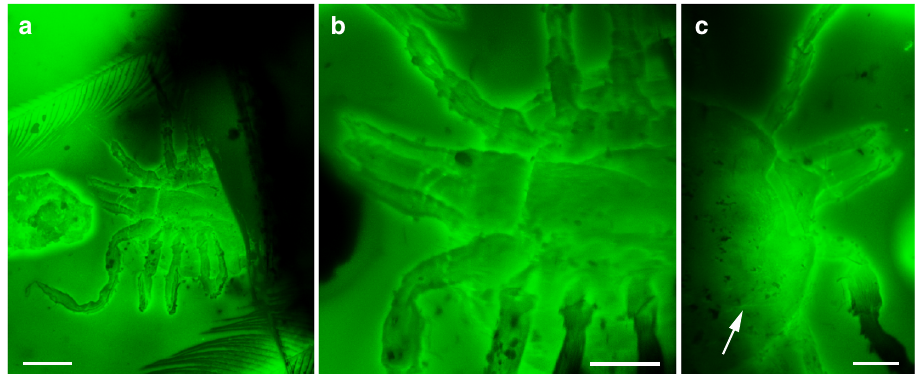
Fig. 2 Confocal laser scanning microscopy images showing the hard tick morphology. a Habitus in ventral view of the Cornupalpatum burmanicum nymph associated with feathers. Scale bar, 0.2 mm. b Detail of the gnathosoma and coxal area in ventral view revealing the absence of genital pore. Scale bar, 0.1 mm. c Dorsal view detail of the gnathosoma and anterior part of the scutum (arrow indicates the lateral margin of the scutum). Scale bar, 0.1